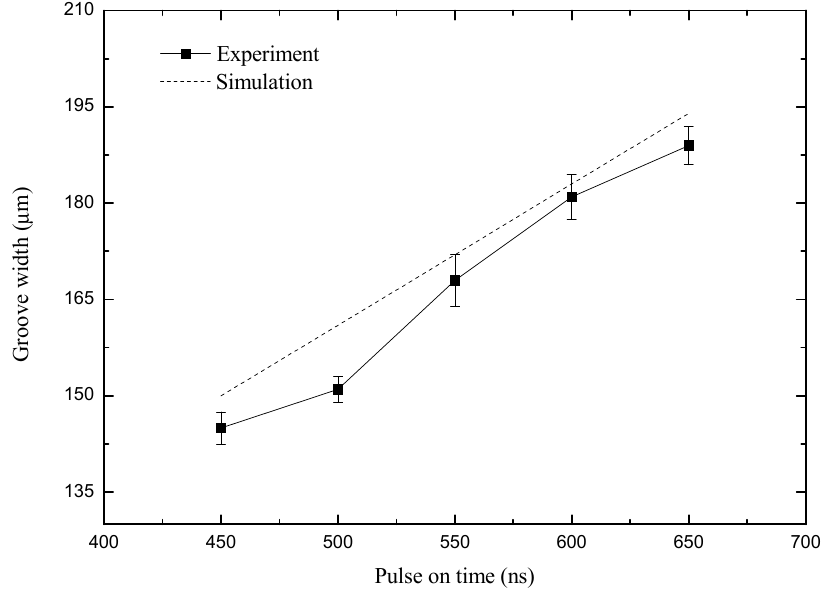
Figure 11. Curve of groove width with the pulse width.